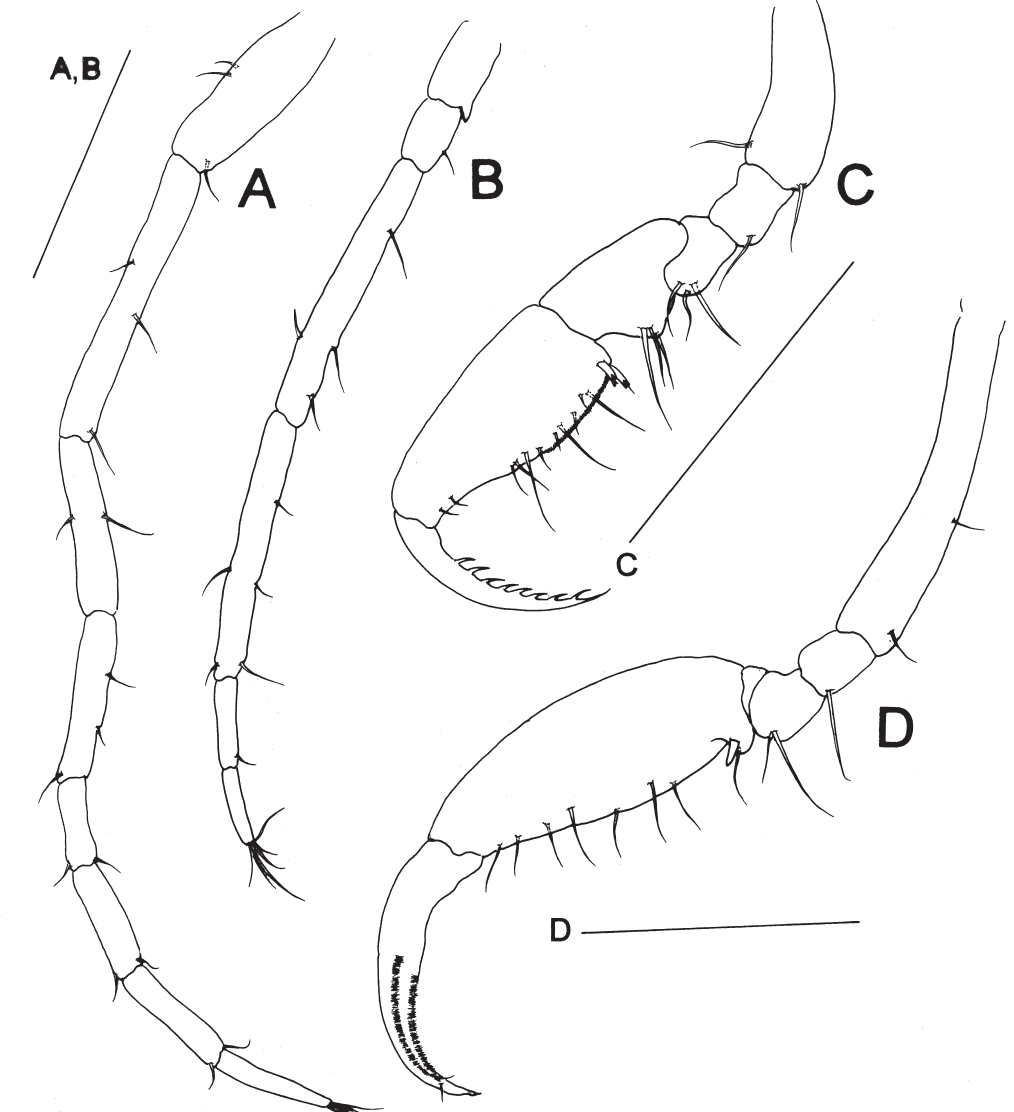
Type material : Holotype male, 2.8 mm. in length from sediment (37º8.43’N, 07º12.03’W), Huelva, southwest Spain, 22 August 2000, 20 meters in depth. Allotype female, 2.33 mm, collected together with holotype. Paratypes: 3 mature males, 5 mature females, 1 juvenile male, 1 premature female, 1 juvenile, collected together with holotype; 4 mature females from sediment (37º06.66’N, 07º19.30’W), Huelva, 23 August 2000, 20 meters in